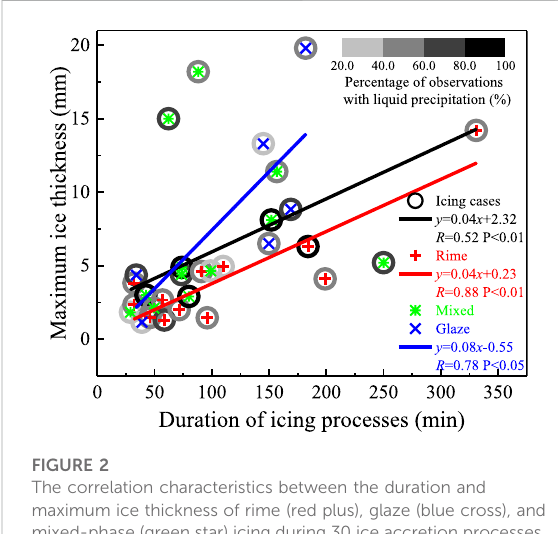
FIGURE 2 The correlation characteristics between the duration and maximum ice thickness of rime (red plus), glaze (blue cross), and mixed-phase (green star) icing during 30 ice accretion processes, with the percentage of observations with liquid precipitation (gray scale; %).